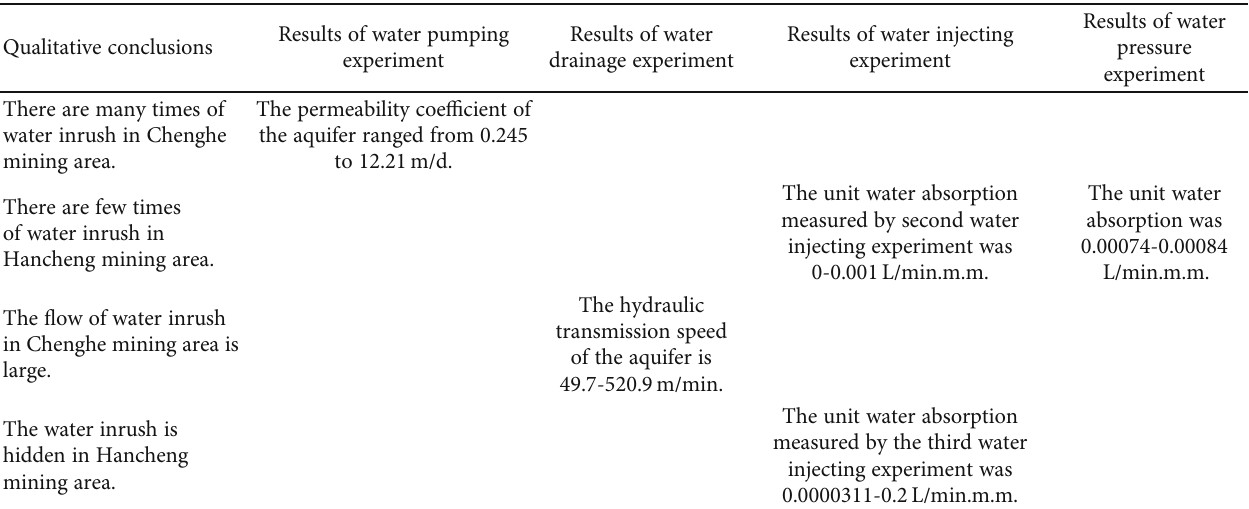
Table 1: Comparative analysis of in situ experiment results and qualitative